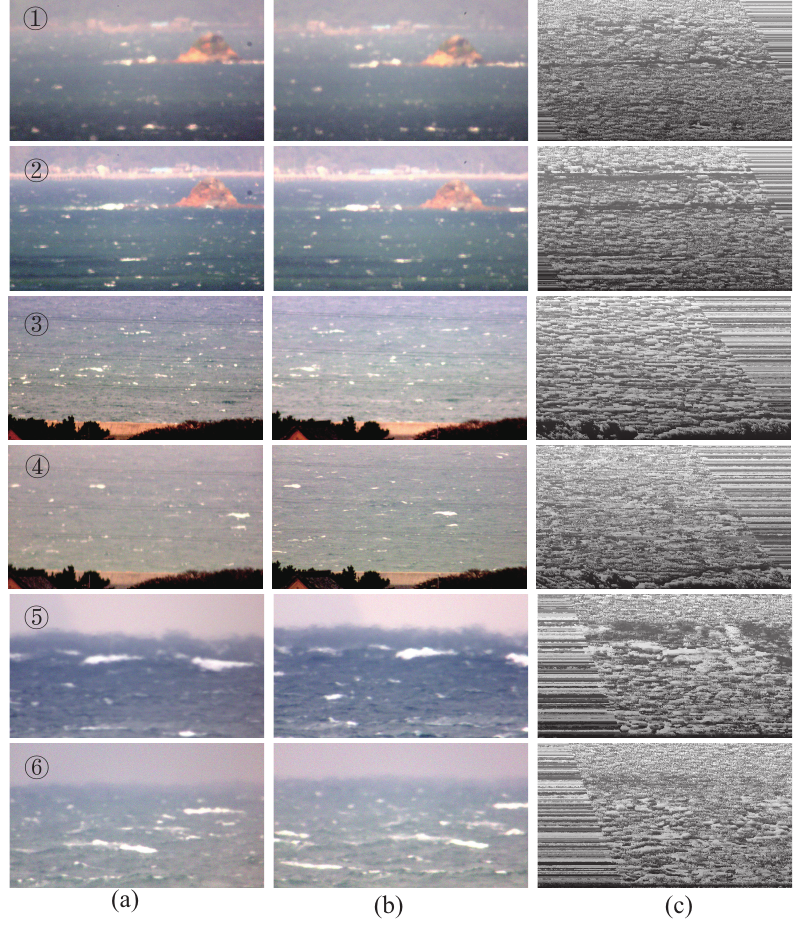
Figure 17. Disparity maps generated by dense matching: 1 (cid:13) and 2 (cid:13) are images taken at 18–23 August 2018 (8–14 km); Rows 3 (cid:13) and 4 (cid:13) are images taken at 8–15 March 2017 (4–10 km); and rows 5 (cid:13) and 6 (cid:13) are images taken at 29 February–6 March 2016 (14–20 km). Column ( a ) shows the images taken by the left camera; Column ( b ) shows the images taken by the right camera; and column ( c ) shows the disparity